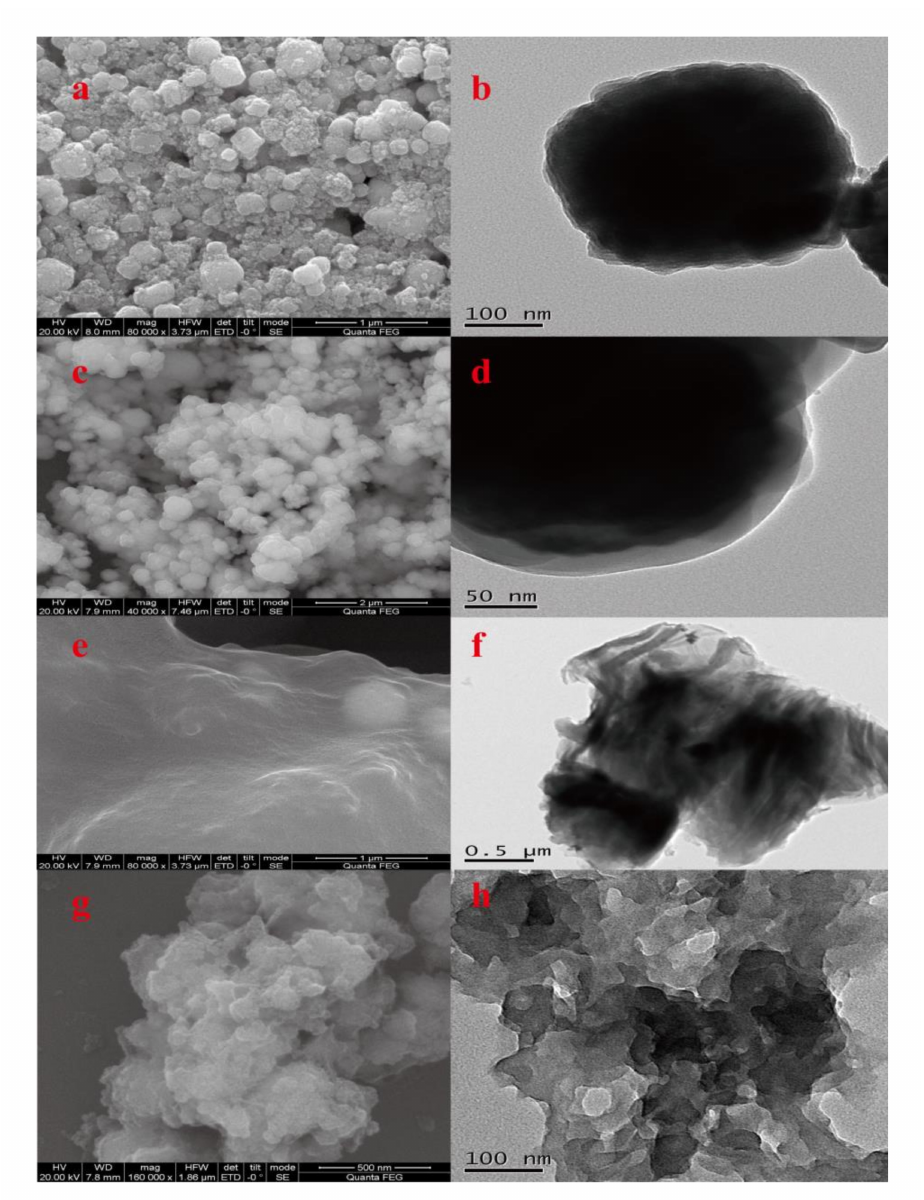
Figure 1. SEM and TEM images of Fe 3 O 4 ( a , b ), Fe 3 O 4 @SiO 2 ( c , d ), Fe 3 O 4 @SiO 2 / CS / GO ( e , f ), and Fe 3 O 4 @SiO 2 / CS / GO / β -CD ( g , h